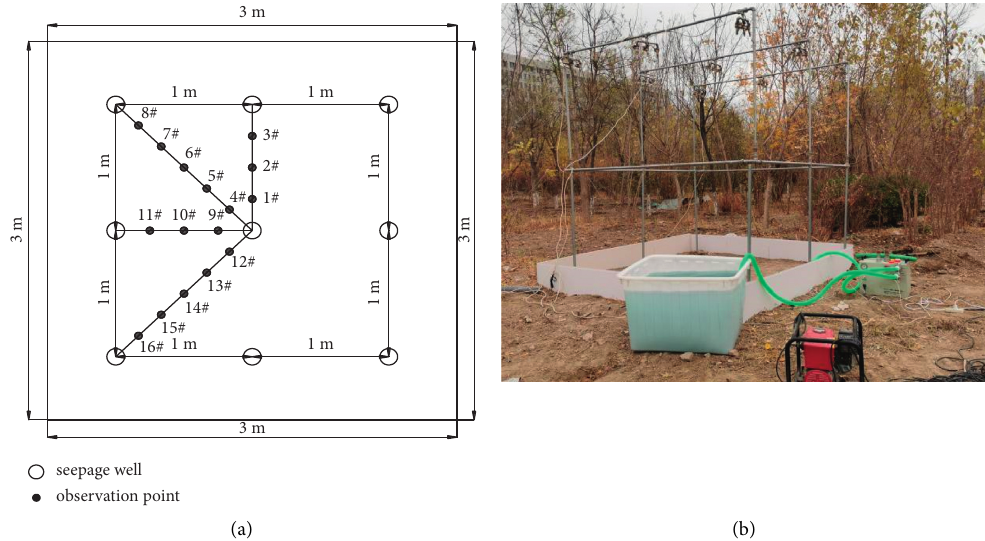
Figure 8: Scheme of test site I with (a) observation points and (b) artificial simulated rainfall system (observation points are set located at equal